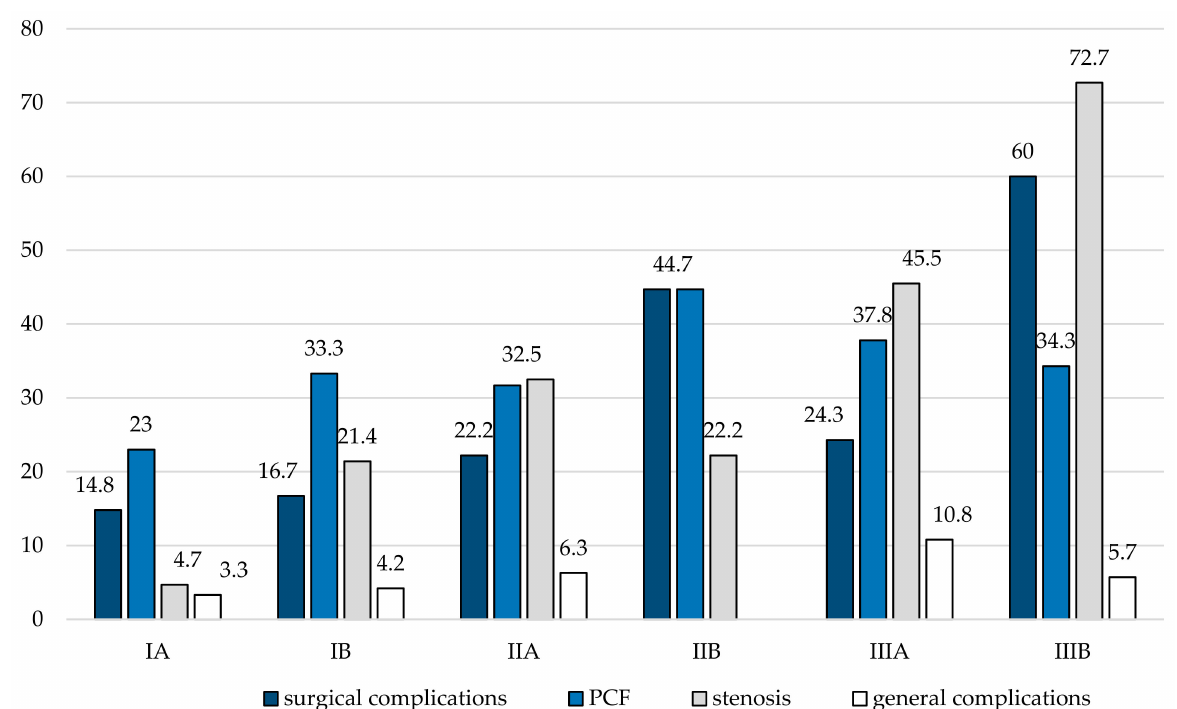
Figure 2. Complications according to the Vienna Laryngopharyngectomy Classification system. Charts showing surgical complications ( p = 0.001), PCF formation ( p = 0.345), formation of stenosis ( p < 0.001), and general complication ( p = 0.001) depending on the extent of ablative surgery (I: laryngectomy; II: laryngectomy with partial pharyngectomy; III: laryngectomy with total pharyngectomy) and whether each surgery was performed in salvage situation (A: non-salvage; B: salvage). Values are given in